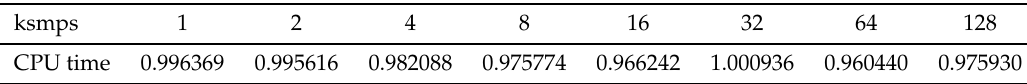
Table 1. CPU time ratio C:C++ of versions of the opcode tone . These results are an average of five runs per test, each processing 600 seconds of audio at f s = 44100 KHz. Tests were run on the x86_64 architecture under MacOS and the clang